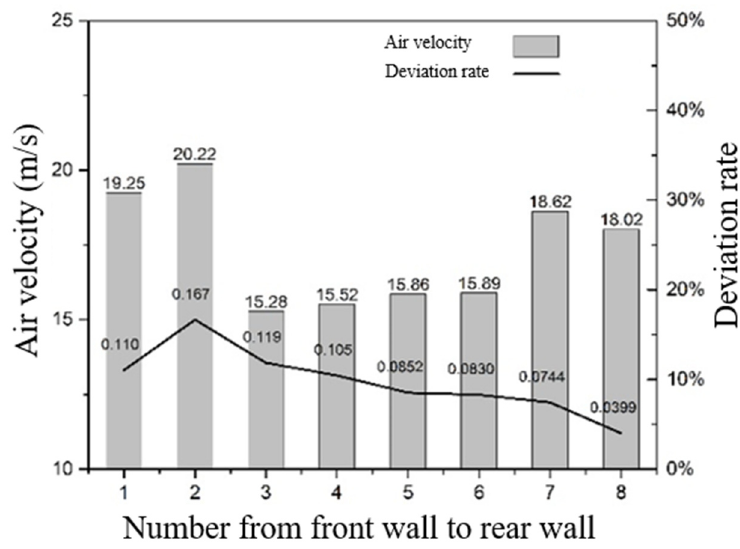
Figure 12. The calculated value of internal side lower secondary air exit